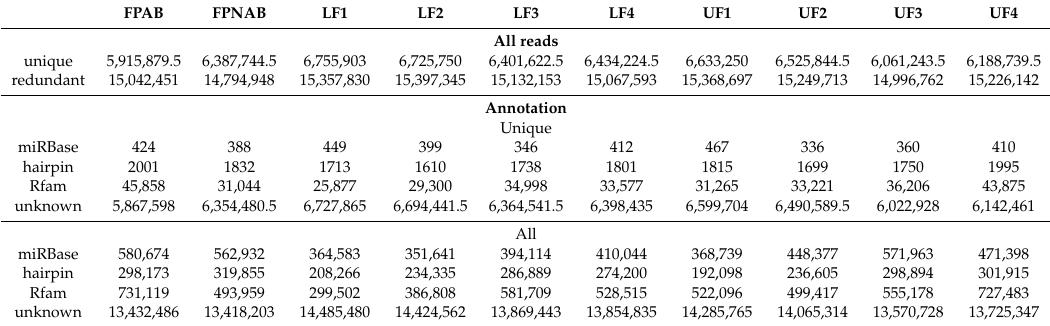
Table 1. Summary of reads and general annotation of small RNA-seq data.